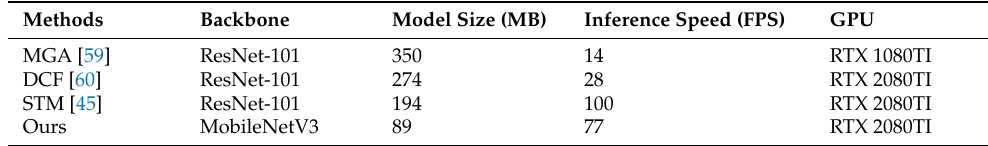
Table 7. Comparison of the recent saliency detection